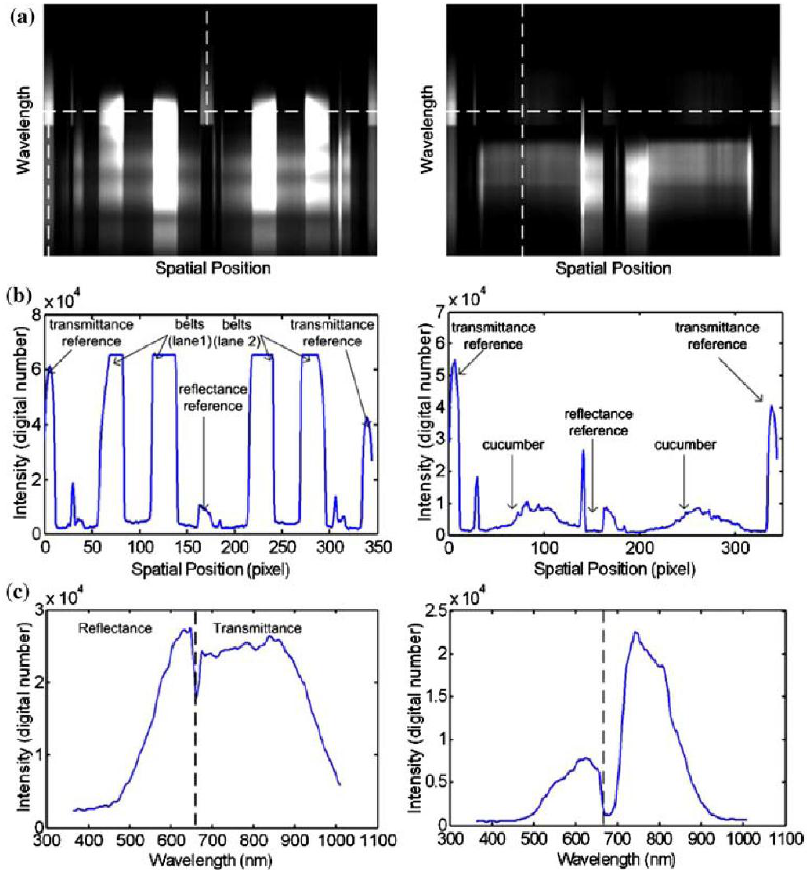
Figure 14. Examples of integrated hyperspectral reflectance and transmittance images and their spatial and spectral profiles (left panel: no sample on the conveyor belts; right panel: cucumbers on the conveyor belts): ( a ) hyperspectral images; ( b ) spatial profiles corresponding to the horizontal dashed lines ( a ); ( c ) spectral profiles corresponding to vertical dashed lines in ( a ). Reproduced with permission from [82], Copyright Springer, 2008.